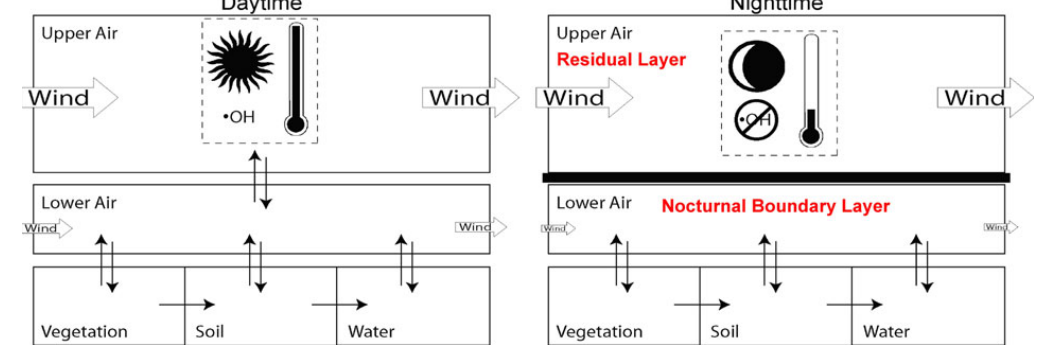
Fig. 1. Multimedia model for the local environment of PCB measurement sites in Z¨urich, Switzerland. The model is based on the BETR model framework [14]. Adapted with permission from MacLeod et al. [17]. Copyright 2007 American Chemical